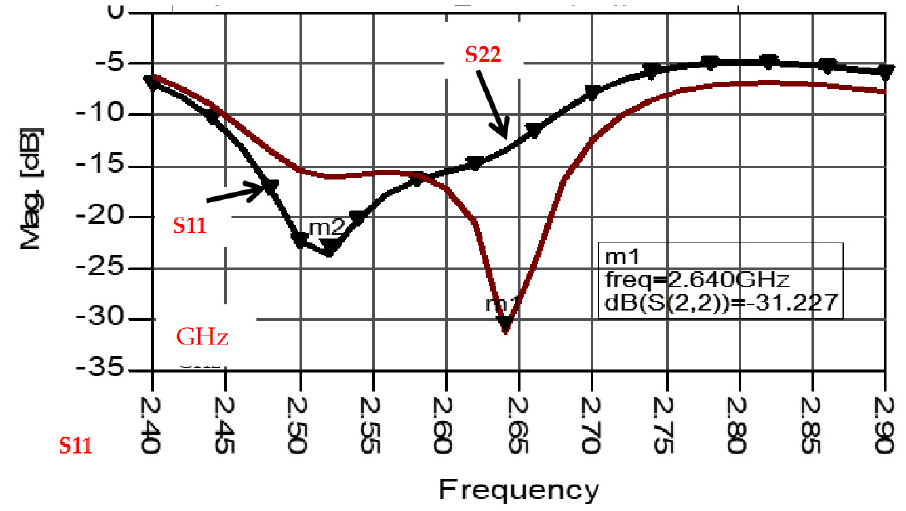
Figure 18. S11 and S22 parameters of the circular polarized Patch Antenna with CSRRs.